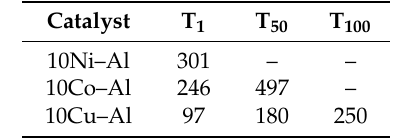
Table 2. The light-off temperature of catalyst samples for CO